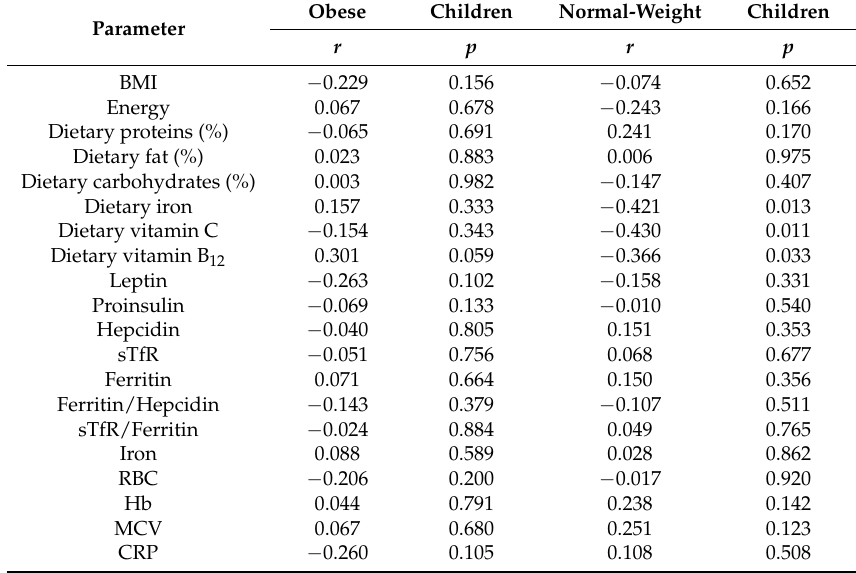
Table 5. Correlation analyses of ferroportin with clinical, nutritional data and iron status parameters in the obese and normal-weight